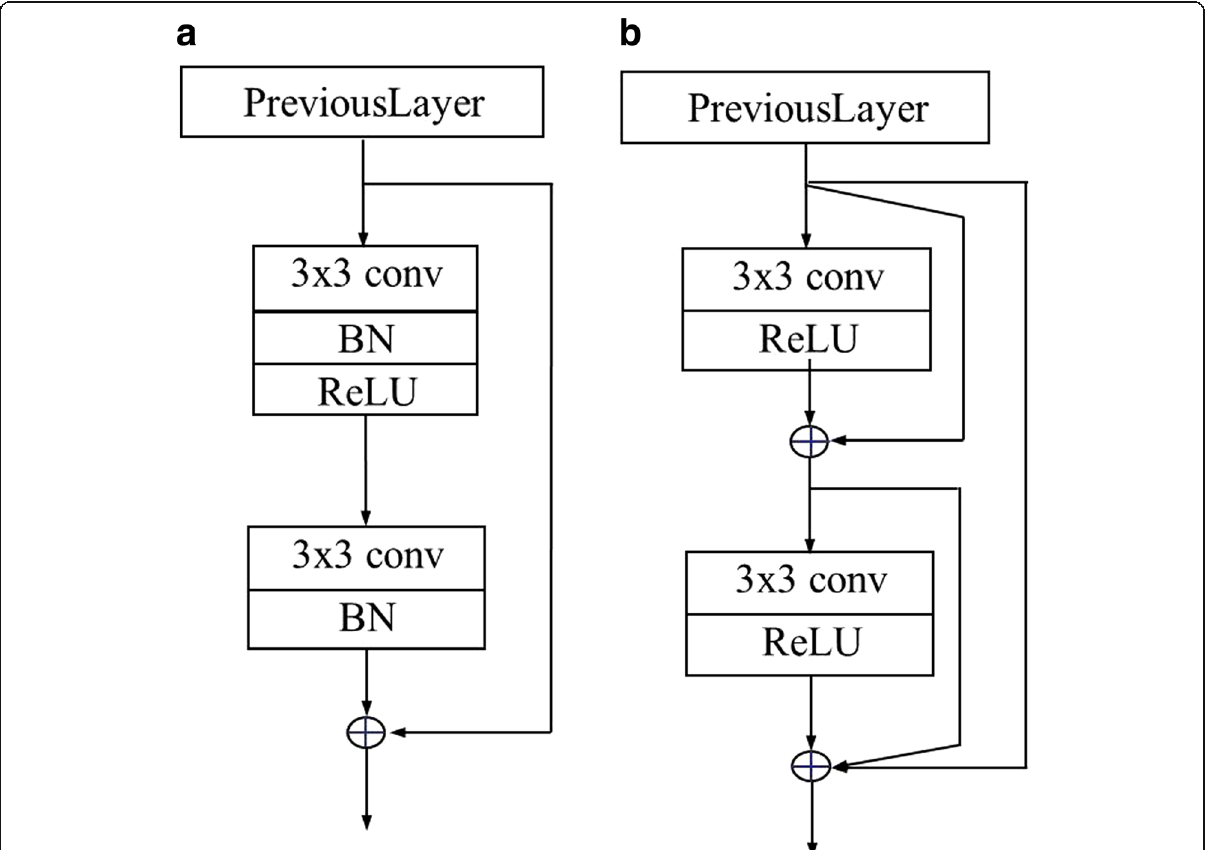
Fig. 3 Traditional residual unit and improved residual unit